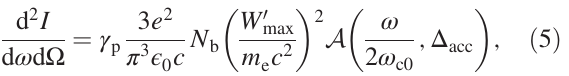
FIG. 4. Observed x ray: (a) E the 10 mm nozzle. Each point is the mean of N ¼ 1 – 10 shots, and bars represent the combined statistical and measurement errors. Curves show predictions using Eqs. (5) and